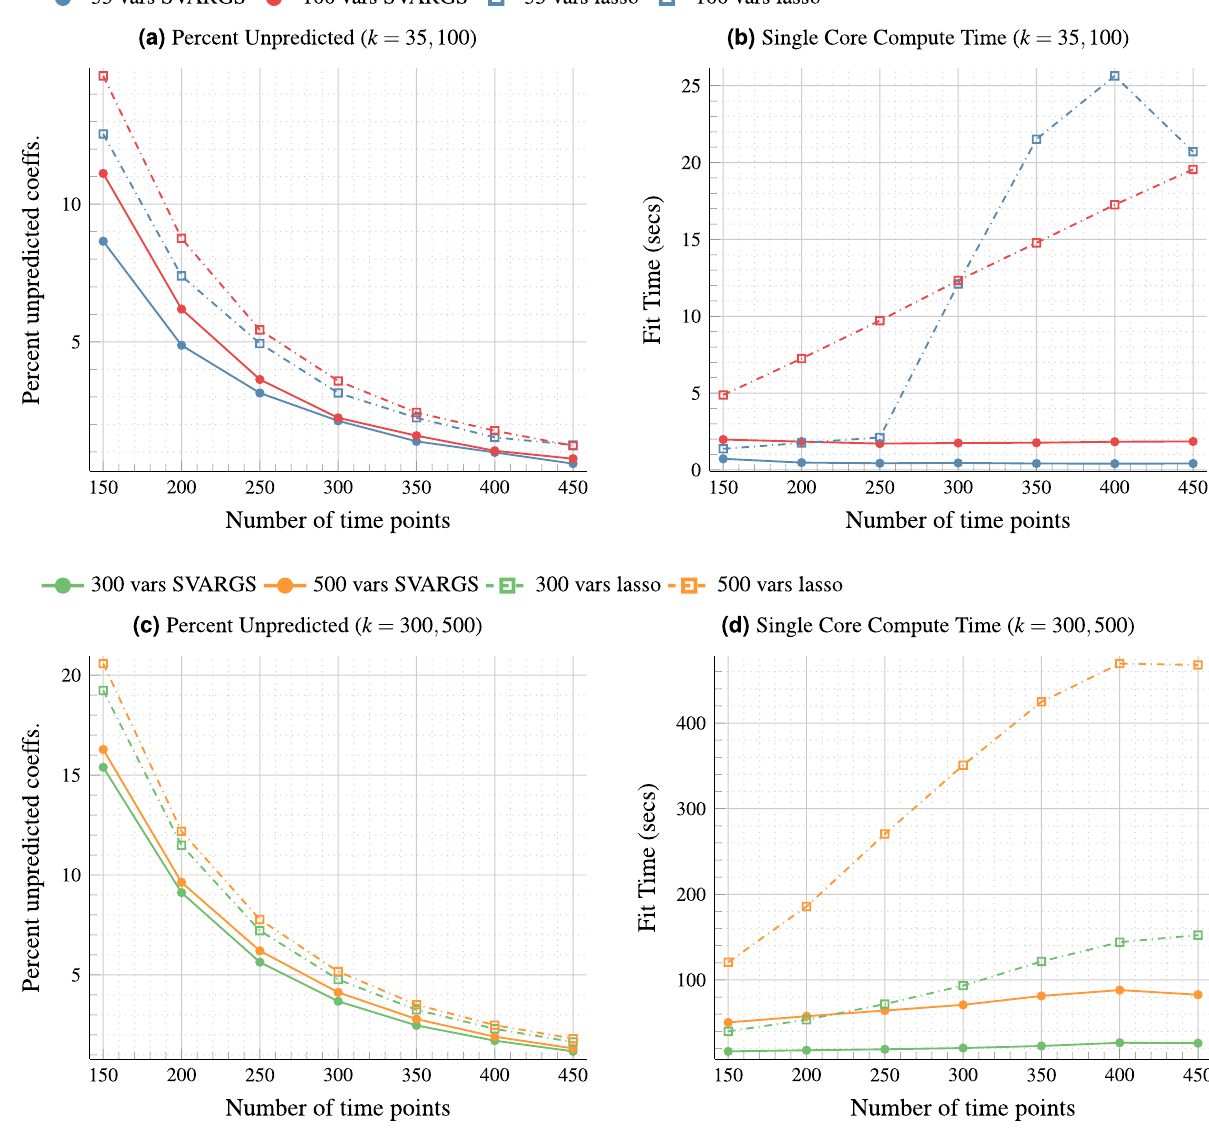
Figure 1. ( a,c ) (left column) Percent Unpredicted (false negative rate) = Number of true non-zero coefficients not in the fitted model)/(Number of true non-zero coefficients) for k = 35, 100 and k = 300, 500 respectively, averaged over 50 samples per data length. ( b,d ) (right column) Time taken in seconds (single processor core) to complete fit for k = 35, 100 and k = 300, 500 respectively, averaged over 50 samples per data length.